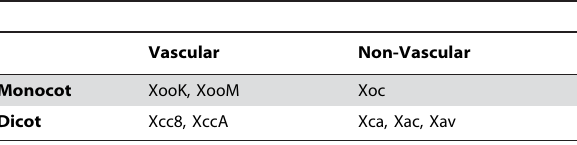
Table 1 . Classification of the examined Xanthomonas strains